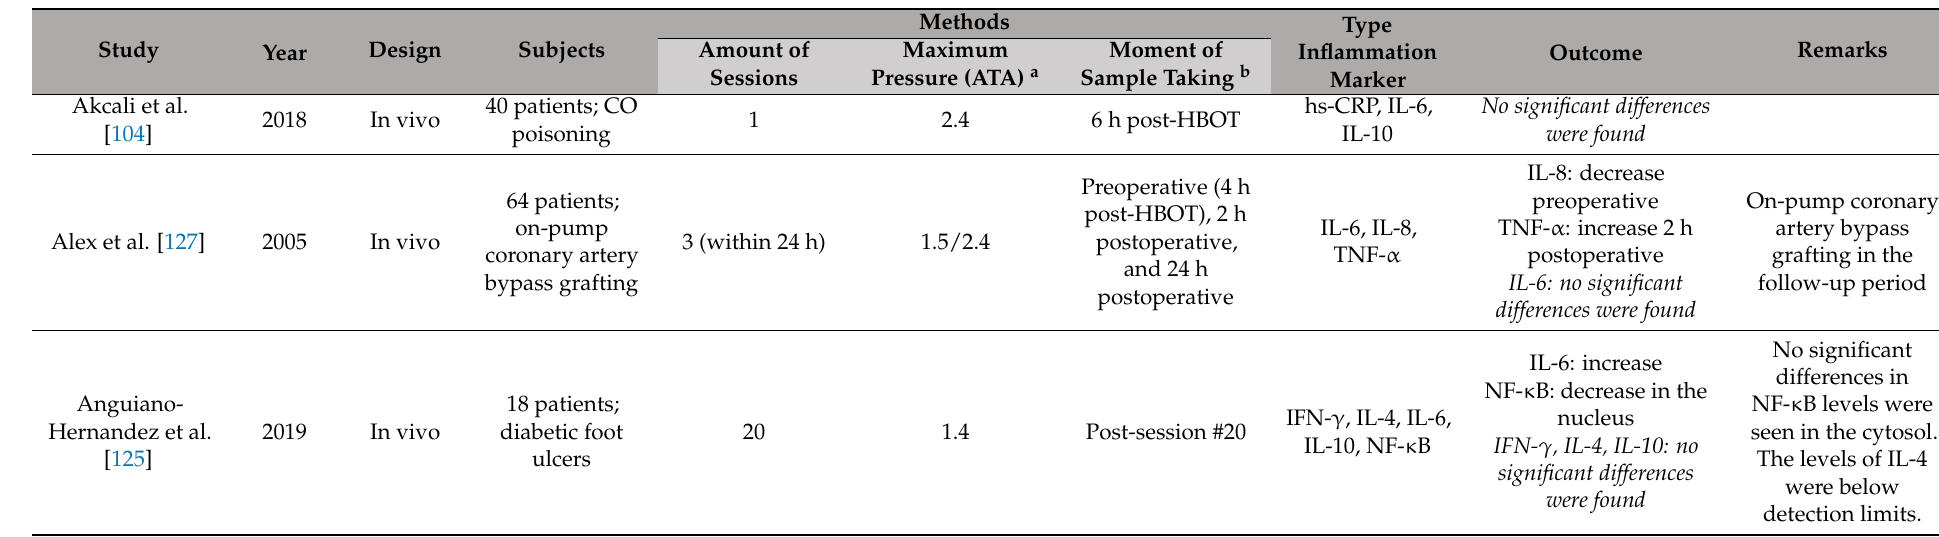
Table A4. Retrieved results on inflammation markers in